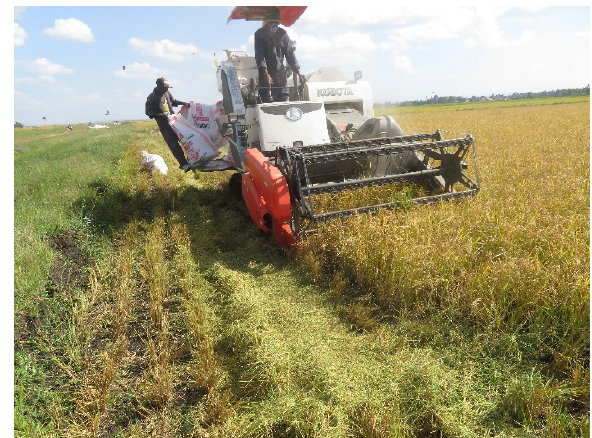
Figure 2. Harvesting of japonica rice.